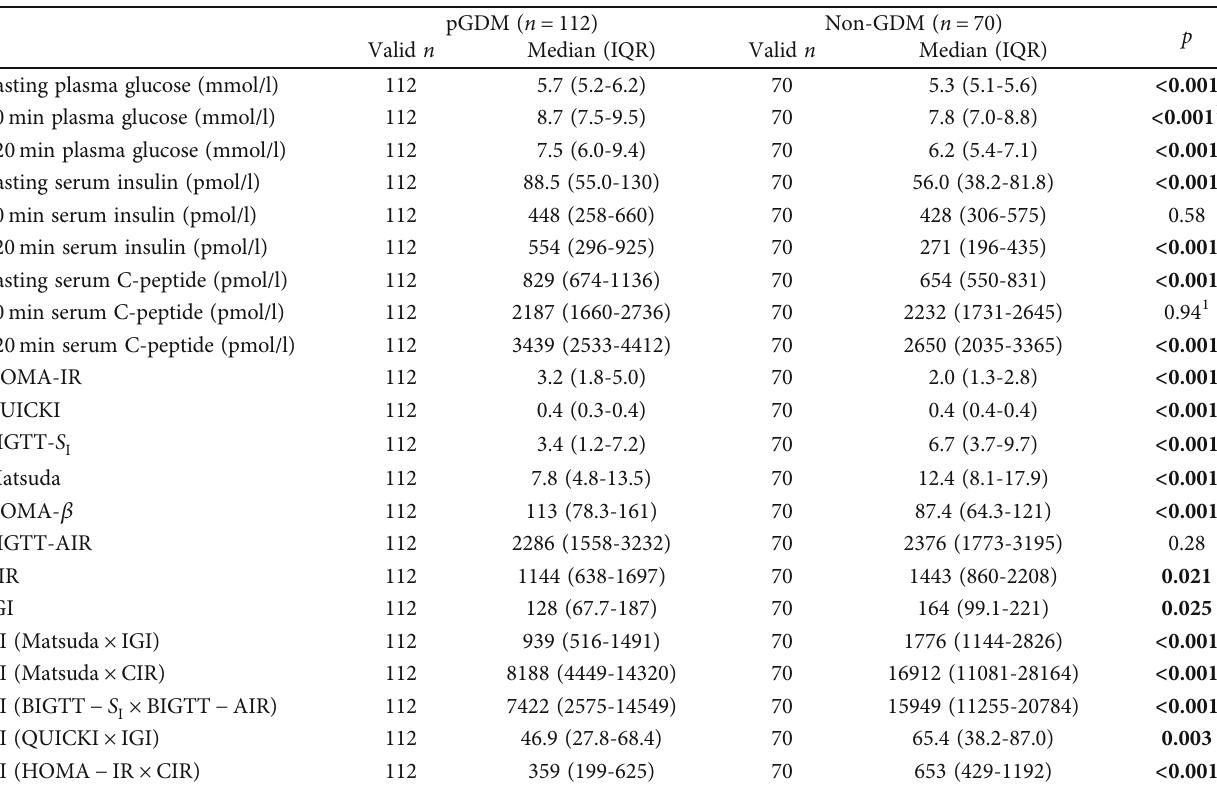
Table 3: Oral glucose tolerance test (OGTT) results and estimates of insulin sensitivity and beta cell function of women with previous gestational diabetes mellitus (pGDM) without diabetes diagnosed before the follow-up assessment and controls